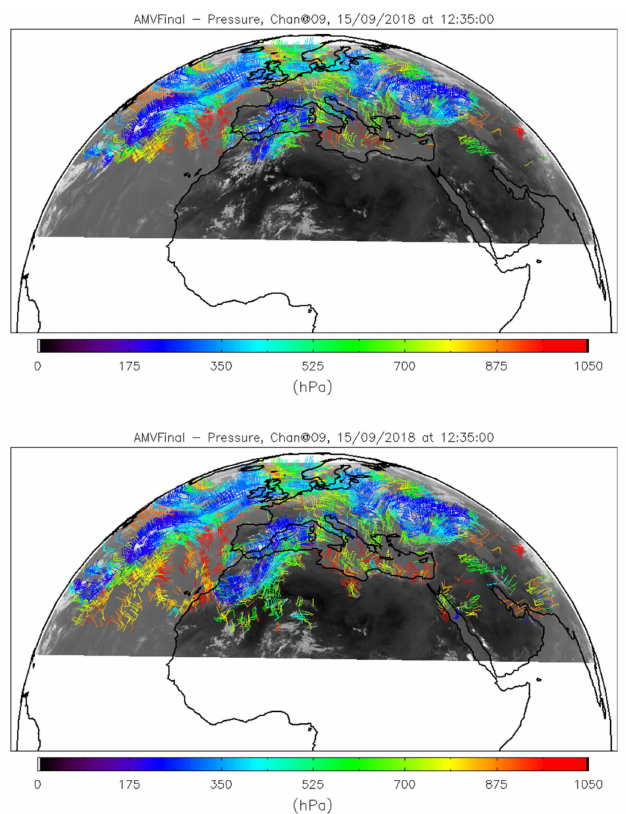
Figure 2. Illustration of the extension of the Rapid Scan Service (RSS) AMV production area from 33.0 (top) to 21.5 (bottom) degrees north. AMVs extracted from Meteosat-9 on 15 September 2018 at 12:30